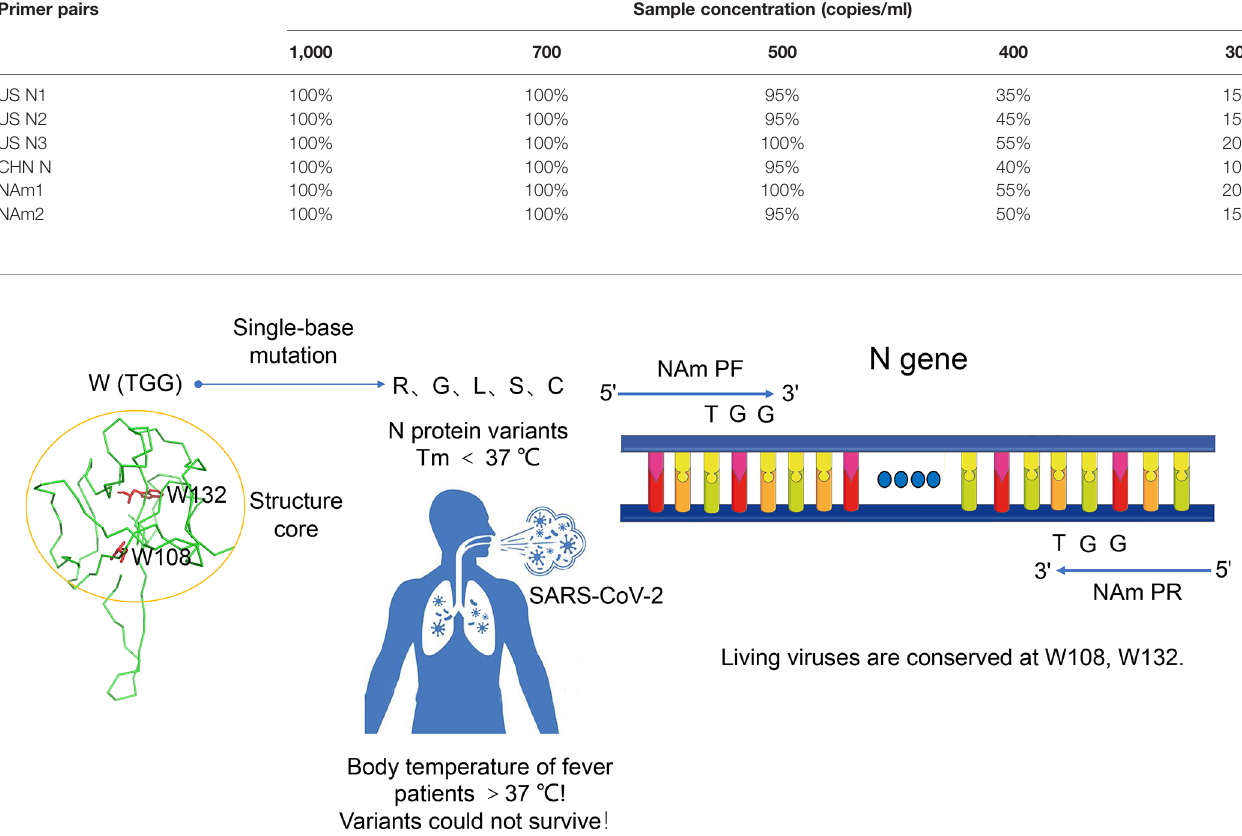
FIGURE 7 | Primer design principle based on protein structure and amino acid